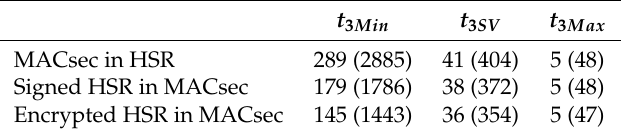
Table 2. Maximum number of nodes for different communication protection according to